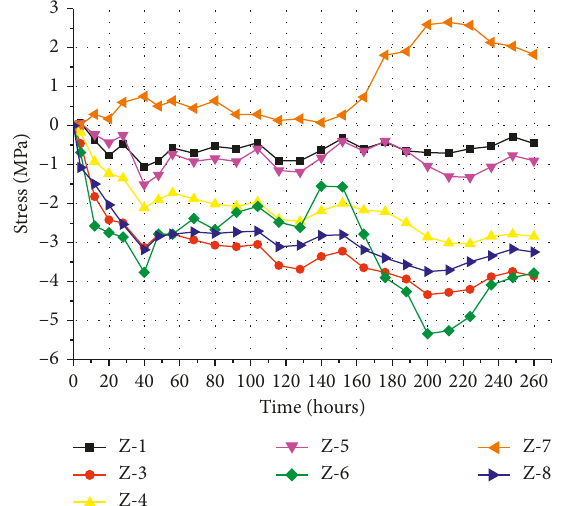
Figure 13: Time history curves of secondary lining stresses of the left tunnel